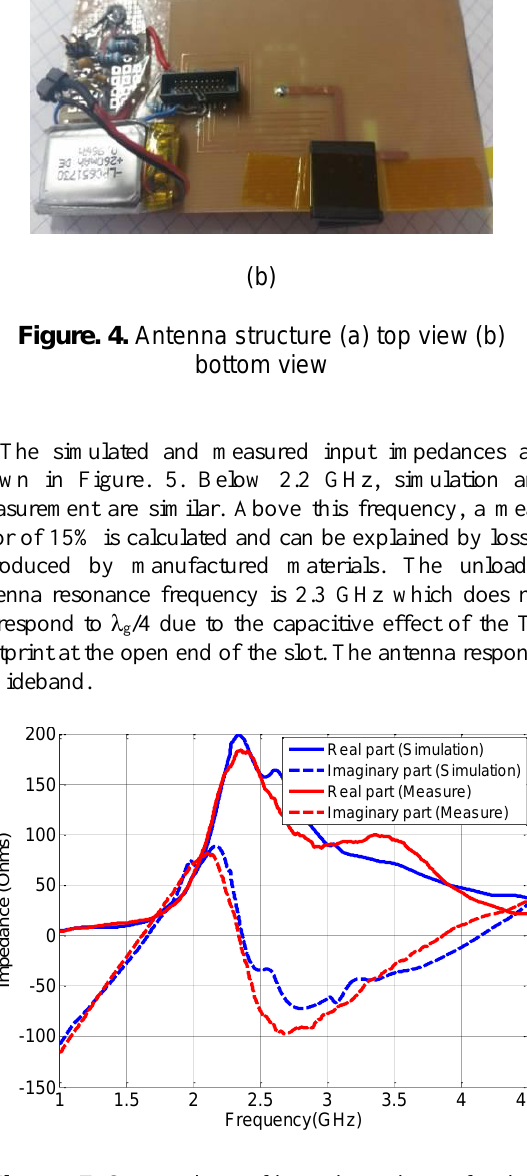
Figure. 5. Comparison of input impedance for the unloaded